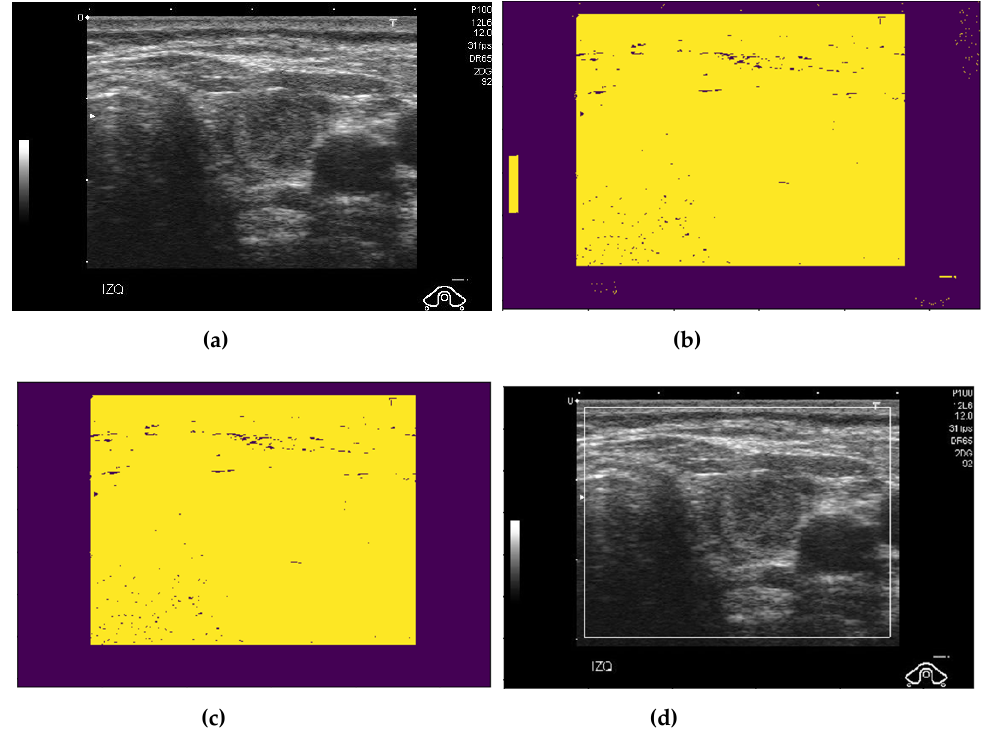
Figure 3. Example result of the thyroid region detection algorithm used in our study: (a) an input ultrasound thyroid image; (b) the binarized image; (c) the thyroid region detection by selecting the largest object; and (d) the final detection results.